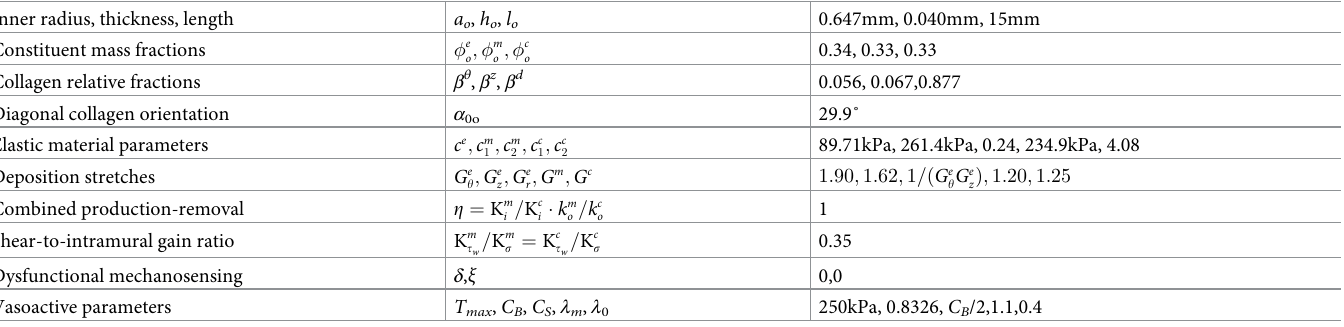
Table 1. Representative values of parameters for the baseline model, a non-aneurysmal mouse descending thoracic aorta, adapted (homogenized through the thick- ness) from [25]. Inner radius, thickness,